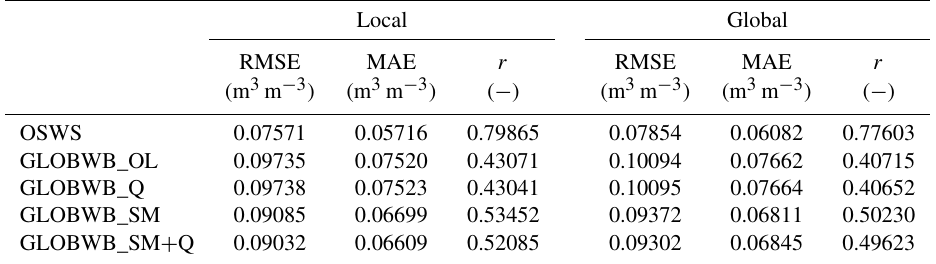
Table A1. Evaluation results of the catchment daily means of soil moisture estimates (the exact values of Fig. 6 are included in this table for